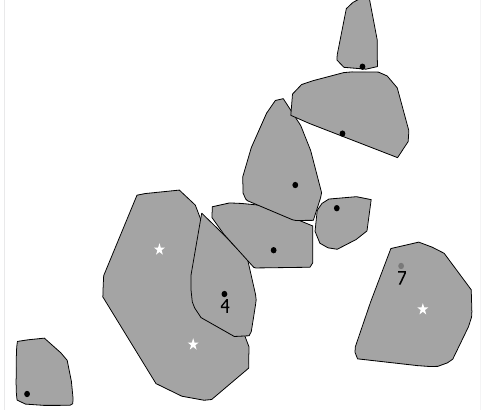
Figure 4. Single-tree segments for some of the sample trees; field measured tree positions of destructively sampled trees (dots) and other trees (stars). Tree #4 was linked to the segment with the nearest centroid (see Section 2.5.1). The segment containing Tree #7 was excluded from the validation dataset, since it also encompassed a tree without field measured crown